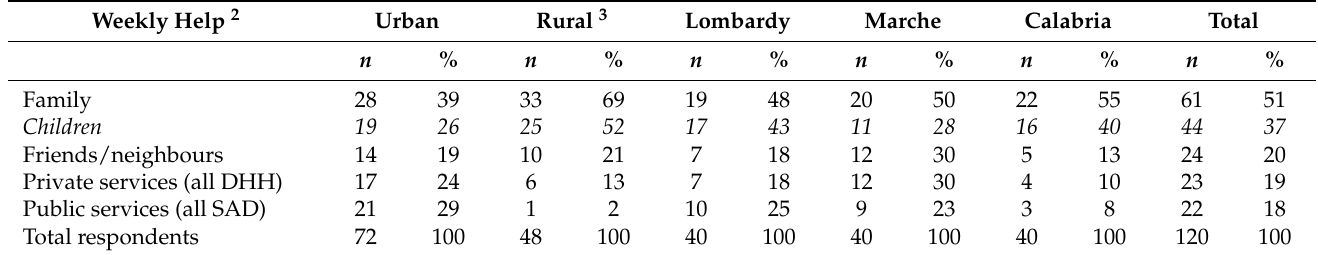
Table 10. Weekly help, by sites and regions (at least one weekly help by type) 1